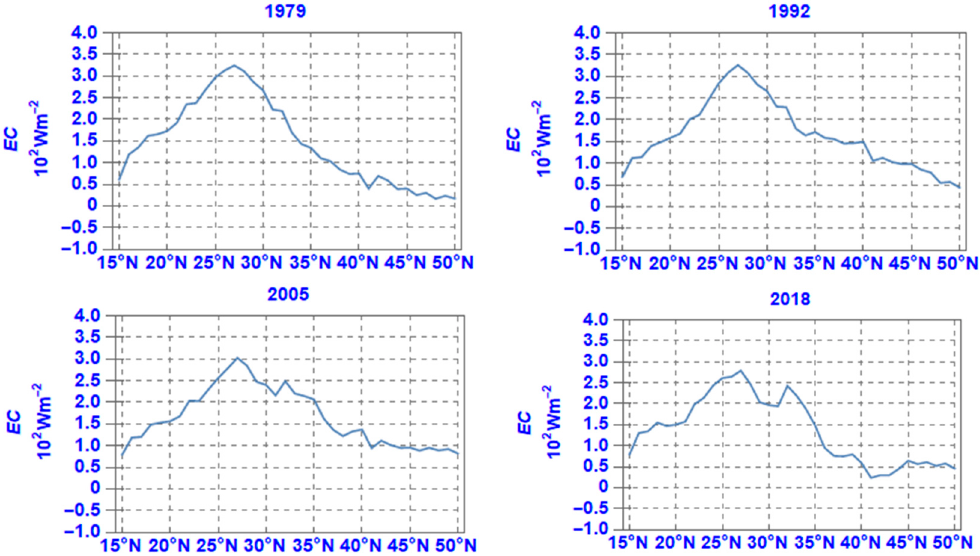
Figure 15. Same as Figure 3, but for EC .